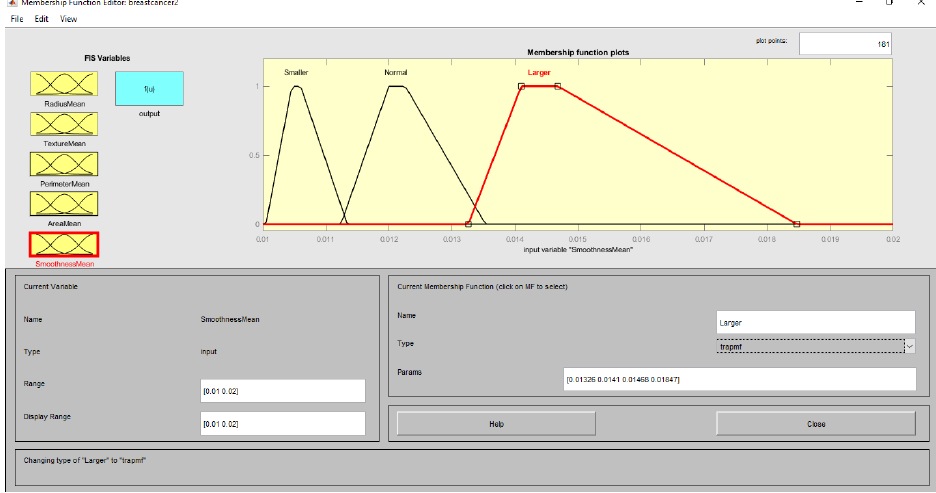
Figure 18. Membership functions of the linguistic variables of smoothness mean input.